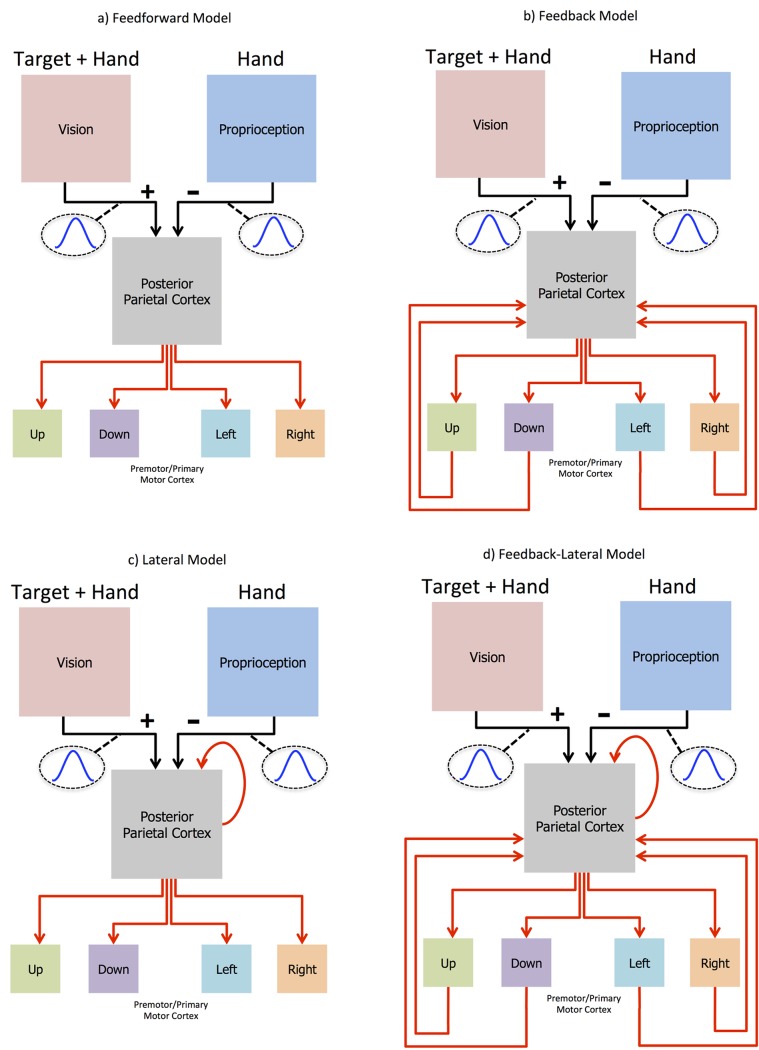
Models.All models have the same general architecture with 121 (11x11) visual neurons (Vision) and 121 (11x11) proprioceptive neurons (Proprioception) feeding forward with opposing 2-D cosine projections (Vision: positive projection with a tuning width of 7 pixels and a maximum amplitude of 2; Proprioception: negative projection with a tuning width of 9 pixels and a maximum amplitude of 4) into 121 (11x11) posterior parietal cortex (PPC) neurons. The visual projections into PPC neurons had half the strength (amplitude) of the proprioceptive projection, to balance out the visual and proprioceptive inputs when the two visual (Hand + Target) representations aligned with the proprioceptive (Hand) representation. The PPC neurons feed forward into the 4 neurons contained within the premotor/primary motor (PMd/M1) cortical region of the network. The black arrows indicate non-evolvable 2-D cosine connectivity between the respective regions. The red arrows indicate evolvable fully connected weights. a) The Feedforward model with fully connected evolvable weights projecting from the PPC to the 4 PMd/M1 neurons. b) The FB model is the same as the FF model along with fully connected evolvable weights projecting back to the PPC from the 4 PMd/M1 neurons. c) The LAT model is the same as the FF model along with fully connected evolvable recurrent weights projecting from the PPC neurons back to themselves. d) The FBLAT model is a combination of the FB and LAT models.